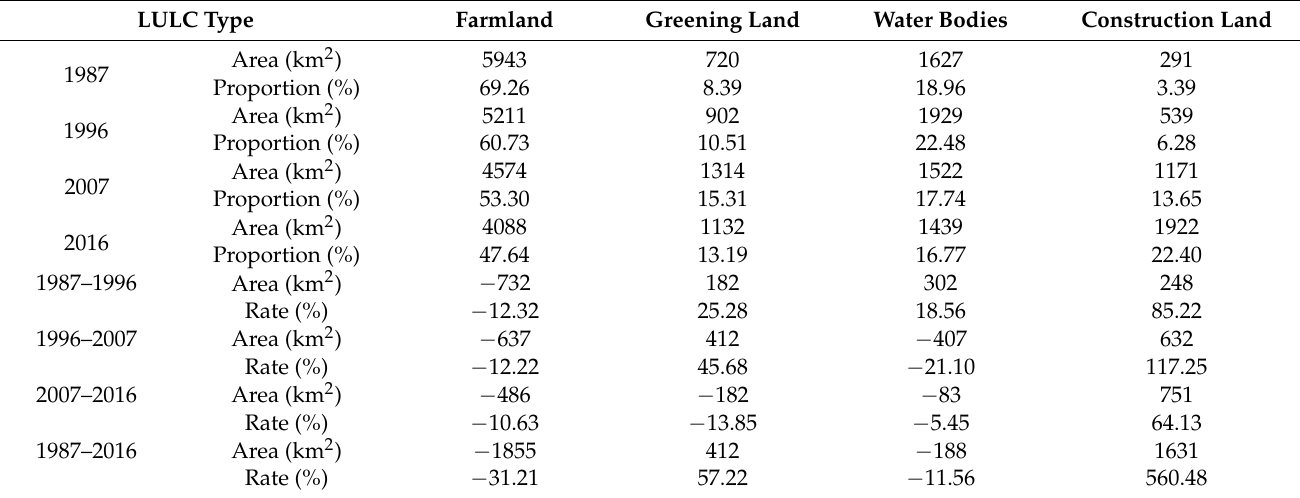
Table 1. Area statistics of different LULC classes during 1987–2016 in